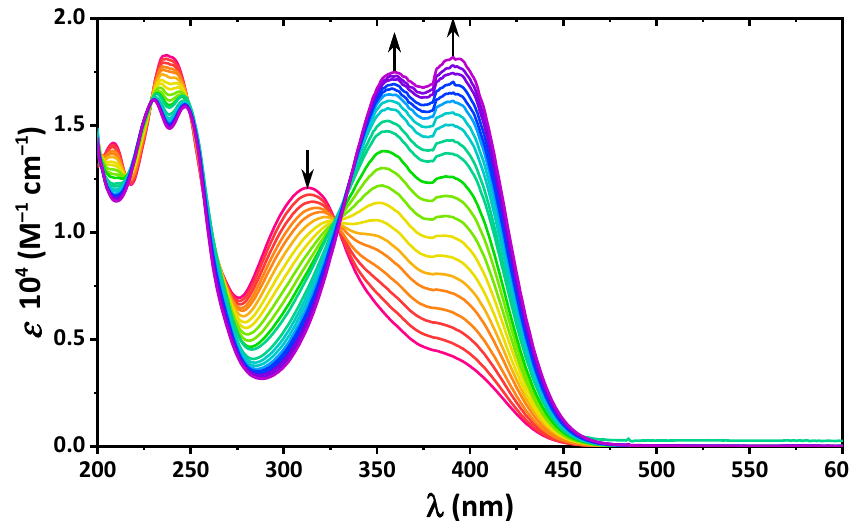
Figure 4. UV-vis spectra of 4 in EtOH upon gradual addition of NaOH up to 2 eqv., with a step of 0.1 eqv.